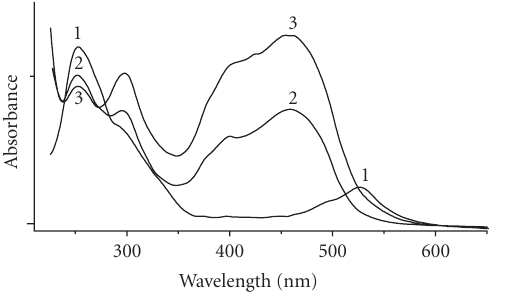
Figure 1: E ff ect of complexation on the absorption spectra of 3 × 10 − 5 M of SP: (1) SP in acetonitrile, (2) SP in the presence of 8 × 10 − 5 M of Eu 3+ in acetonitrile, (3) 3 × 10 − 5 M of SP in the presence of 8 × 10 − 5 M Tb 3+ in acetonitrile.